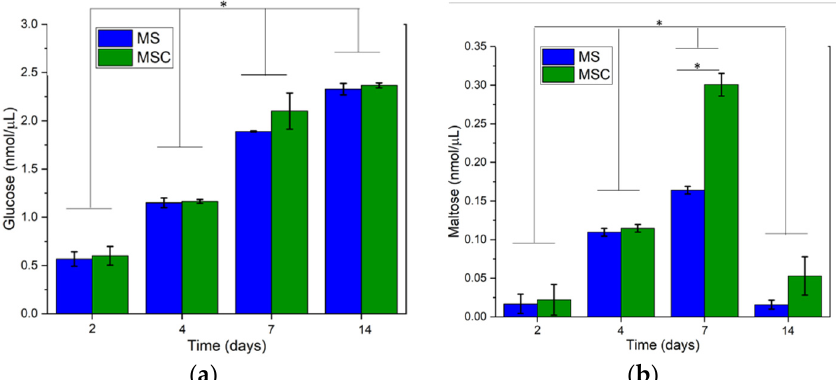
Figure 4. The amount of ( a ) glucose and ( b ) maltose formed during enzymatic degradation of MS and MSC. Significant increase of maltose and glucose was observed at the different time points. The sample MSC did not show any significant difference compared to MS except for values of maltose at 7 days (* p < 0.05).